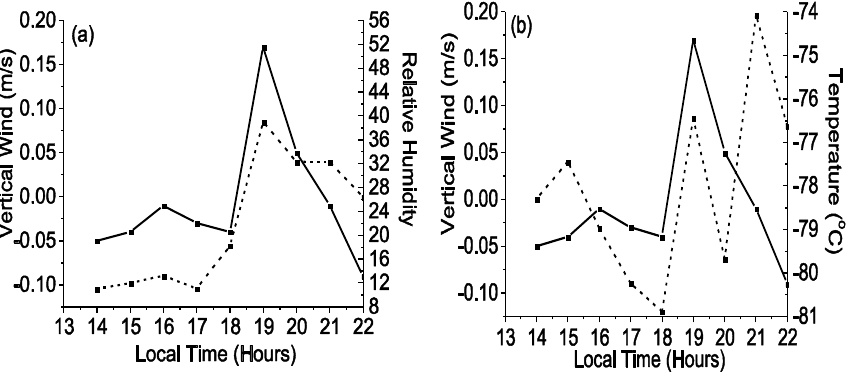
Fig. 14. (a) Temporal behavior of humidity (dotted line) and vertical wind (solid line), (b) temporal behavior of temperature (dotted line) and vertical wind (solid line) in the lower stratosphere (19km height) on 9 December 2005.